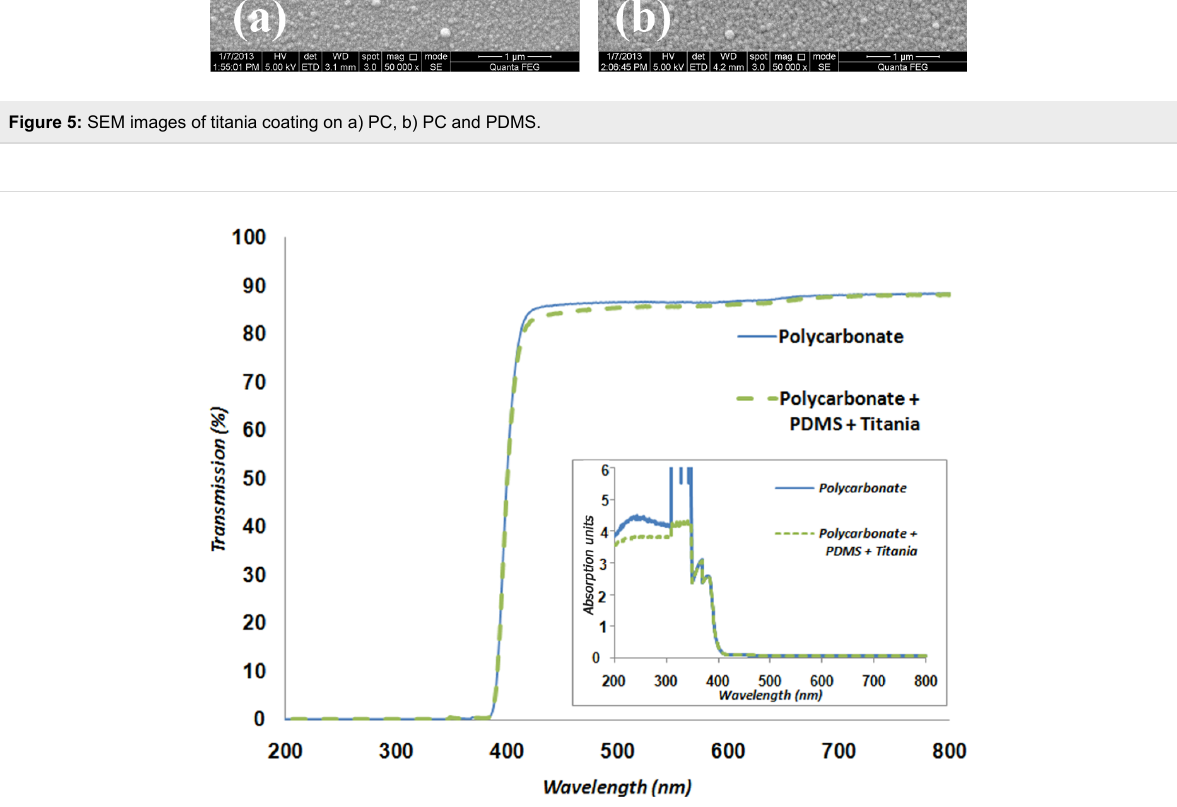
Figure 6: UV–vis spectra for PC with and without titania/PDMS coating. Blue is uncoated PC and green is coated PC; both show no evident absorp- tion in the visible region.